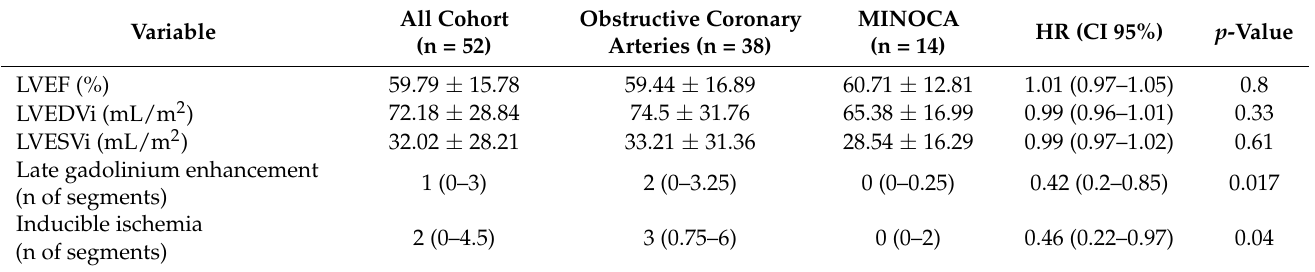
Table 4. CMR subanalysis in NSTEMI elderly patients with obstructive coronary arteries vs.